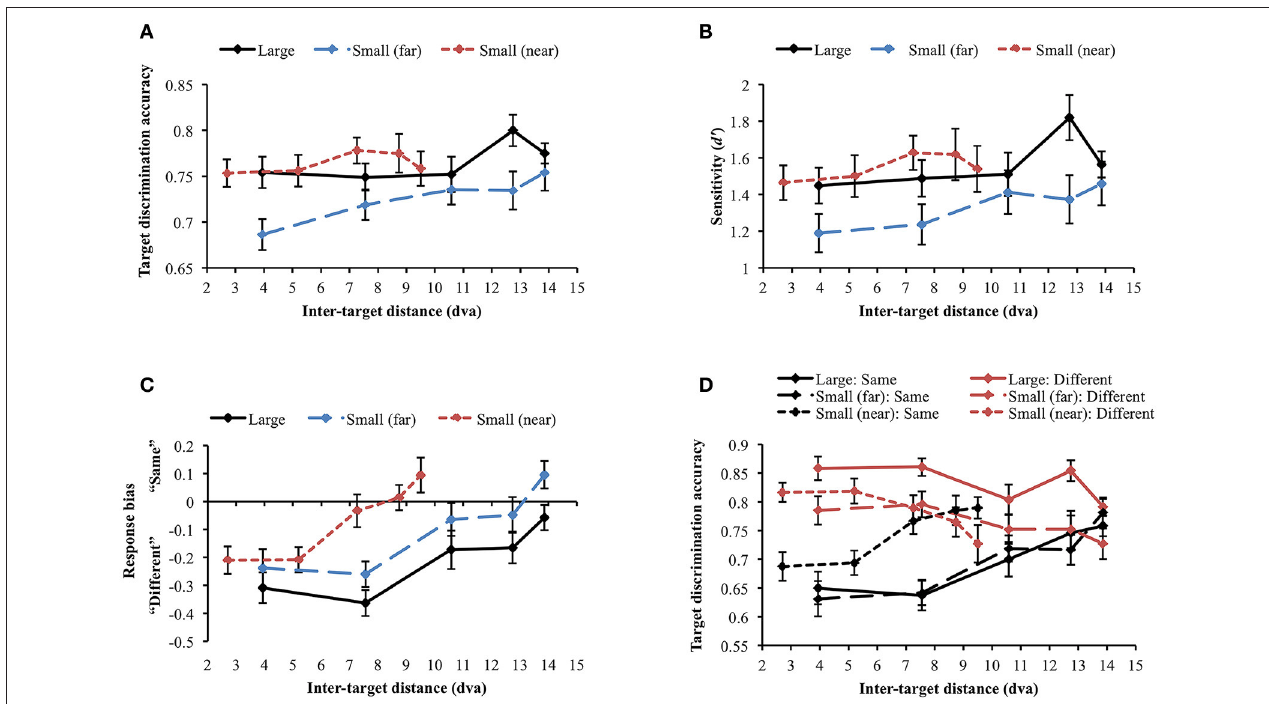
FIGURE 7 | (A) Target discrimination accuracy and (B) sensitivity for face stimuli. No clear evidence for surround suppression was observed in both measures. (C) Participants tended to respond “same” more often as inter-target distance increased. (D) The identity of target faces affected target discrimination accuracy in different ways. Discrimination accuracy was greater when different faces were presented as the target stimuli (red lines), whereas it suffered when the target stimuli were the same face (black lines). Only same target faces produced attentional surround suppression. Error bars indicate